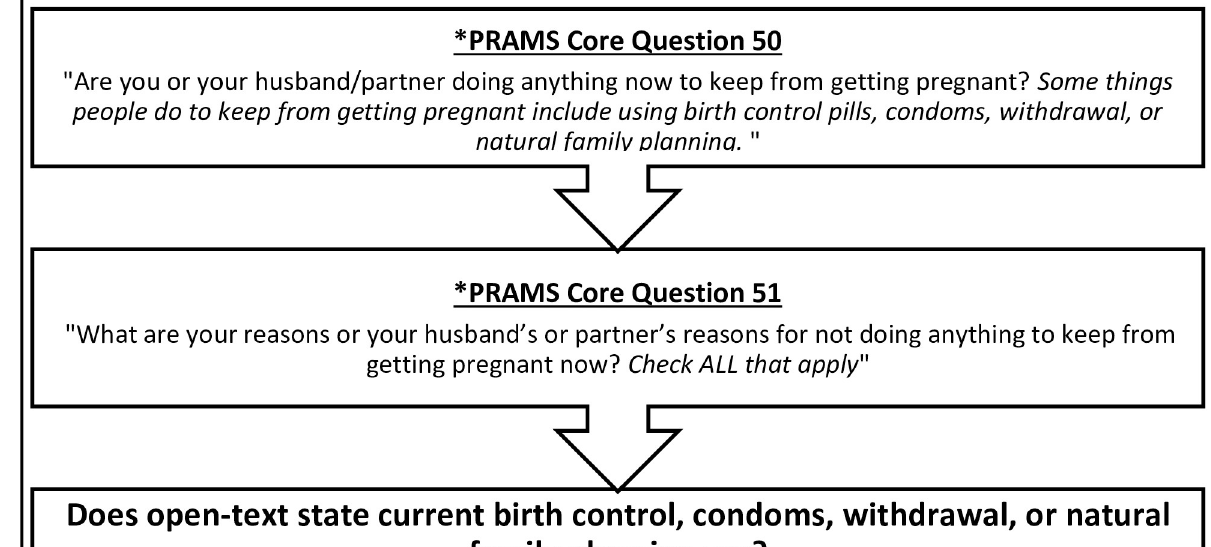
Fig 1. Steps for qualitative recoding PRAMS Phase VII core question 50 and 51 via open-text responses. Researchers used this tool to ensure consistent coding and recategorization of contraception behavior responses. NFP, natural family planning; PRAMS, Pregnancy Risk Assessment Monitoring